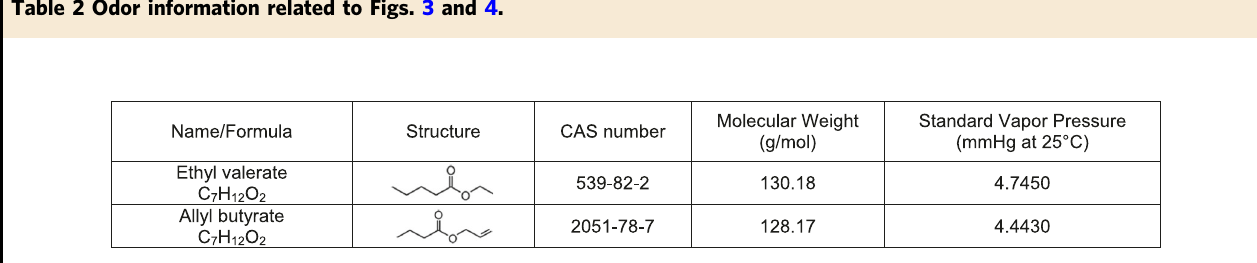
Fig. 3 Antagonism in OSN axon terminals for odors with overlapping activation patterns. a Experimental setup. Same as Fig. 1, but for an odor pair with overlapping response pro fi les (Ethyl valerate and Allyl butyrate). b Image of glomeruli and selected ROIs from one of fi ve mice in this dataset. Odor responses for each odor and their mixture are shown on the right. Colored circles correspond to ROIs in image. Red bar under traces denotes odor delivery time. Scale bar in image is 50 µ m. c Example response curves from selected glomeruli. Data are plotted the same as in Fig. 1. d Data from 20 randomly selected glomeruli, rank ordered by the mixture response. Each point is the mean response to the three highest concentrations of each odor. Error bars are SEM. e – g Data from 226 glomeruli, plotted the same as in Fig. 1. Table 2 Odor information related to Figs. 3 and